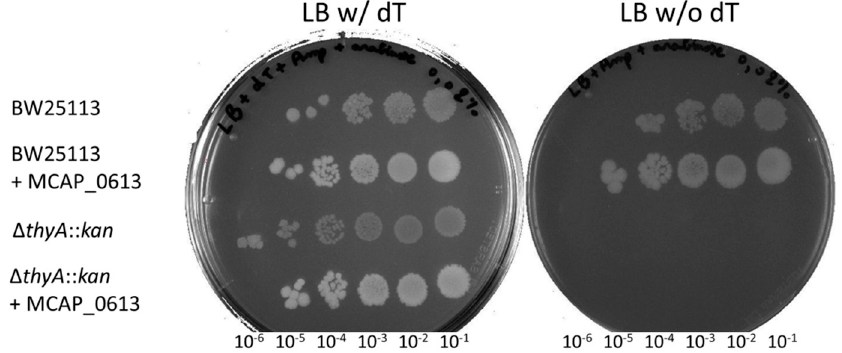
Figure 7. Complementation tests of ∆ thyA ::kan E. coli strain. Cells were grown as described in Materials and Methods. Serial dilutions were spotted from right to left, as indicated. and Methods. Serial dilutions were spotted from right to left, as